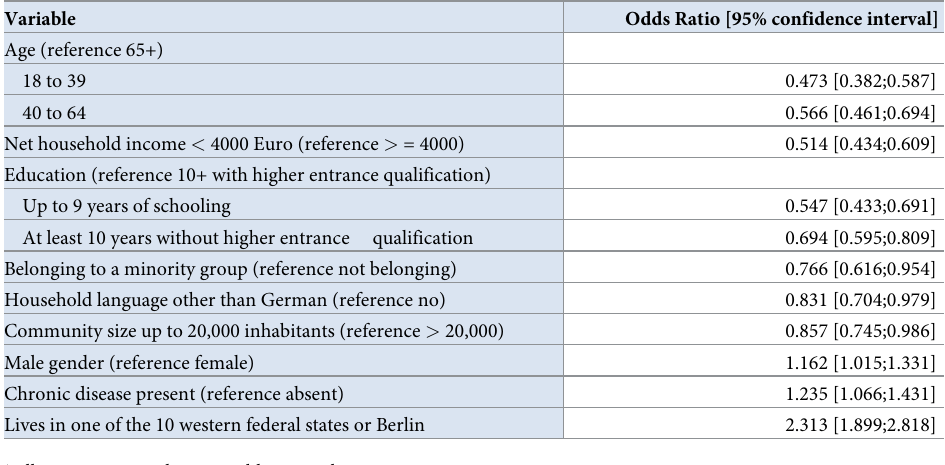
Table 2. Predictors of download of the Corona Warn App (n = 3762) � . Results of the multivariable logistic regres- sion model. Odds Ratios below 1 indicate a decreased probability of download as compared to the reference group, odds ratios above 1 indicate increased